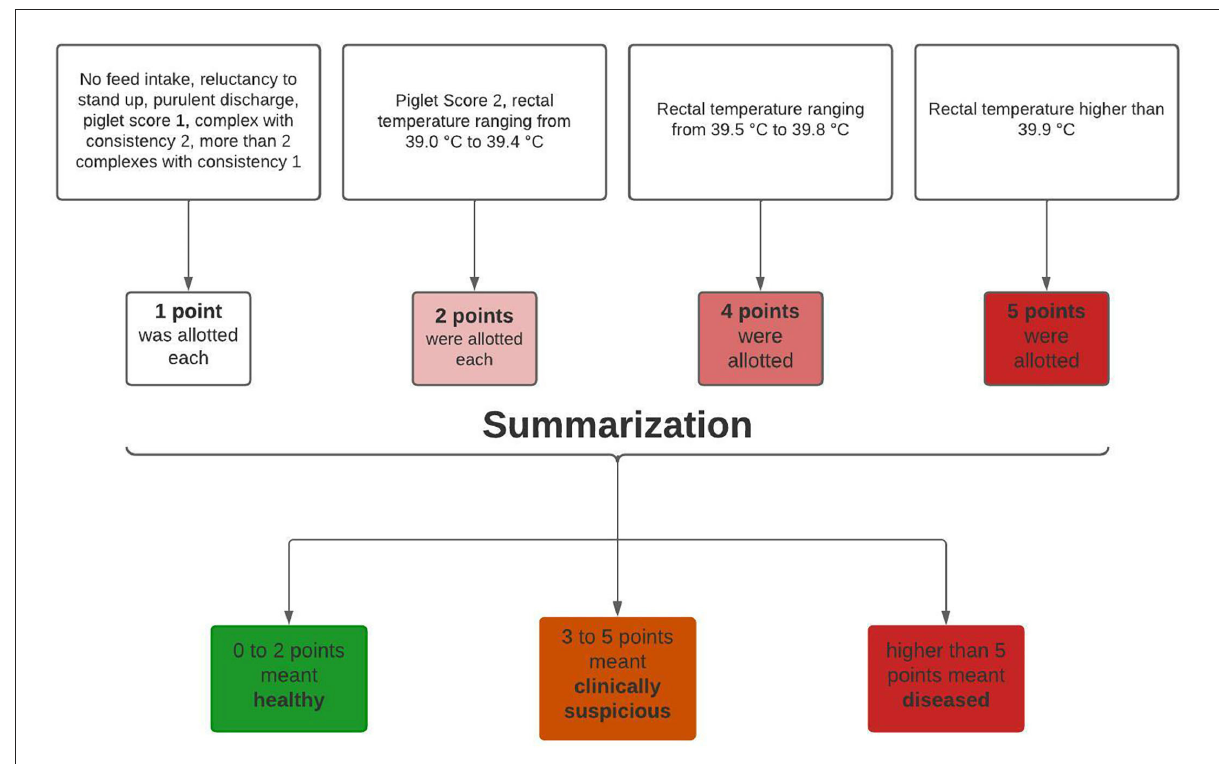
FIGURE3 Schematic diagram about aggregation of clinical data. Adapted from Rosengart et al. (18).